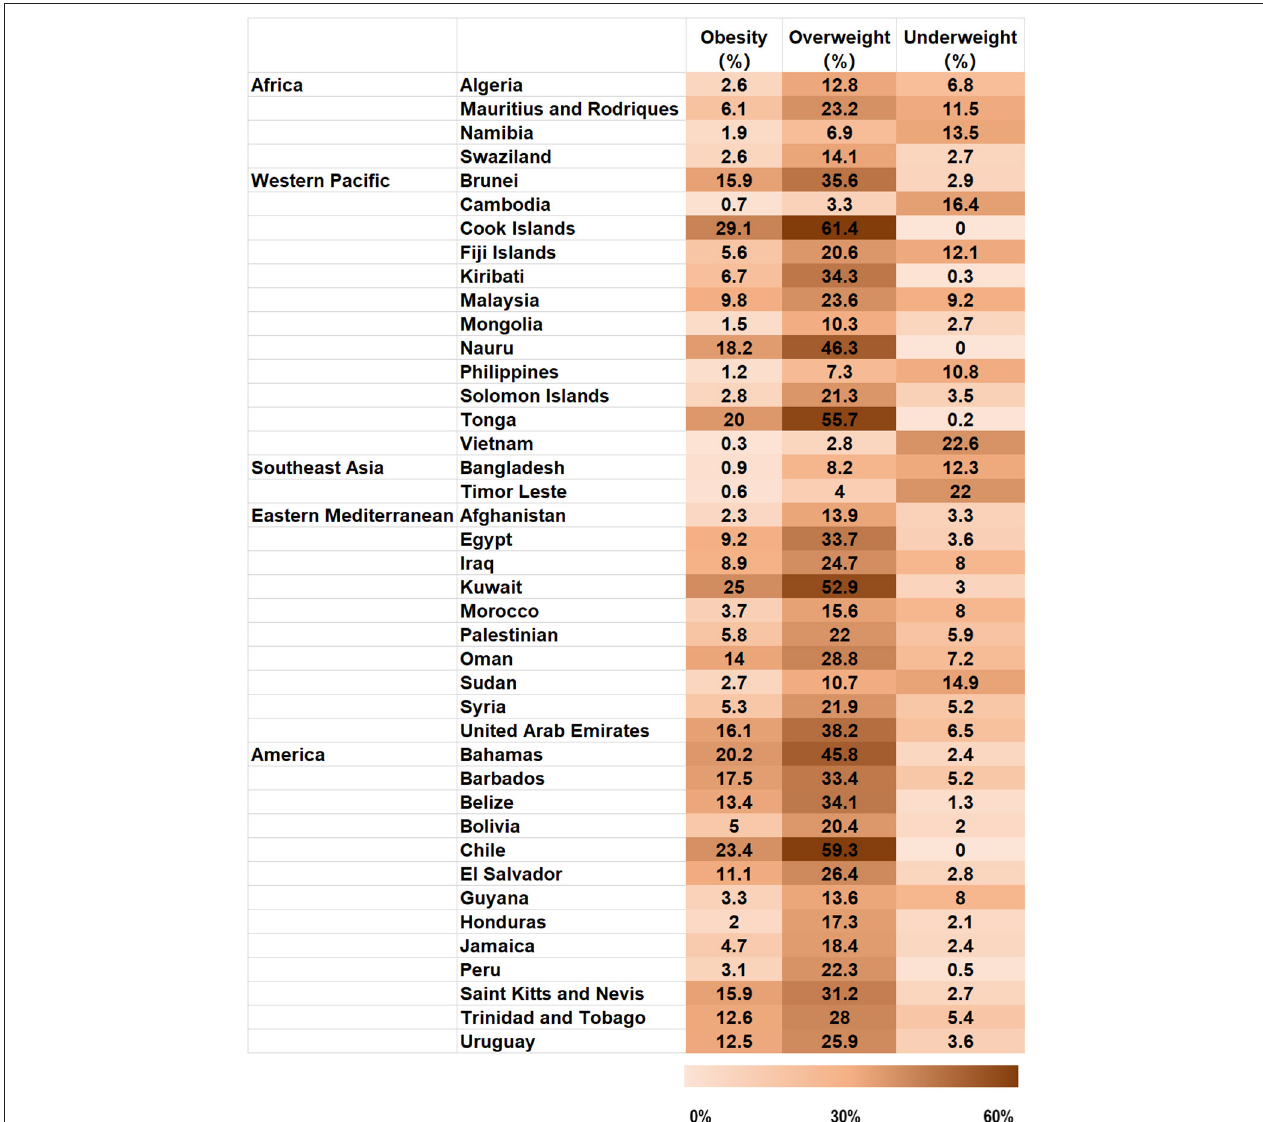
FIGURE 1 | Proportions of obese, overweight and underweight adolescents with hunger aged 12–15 years, organized by country.